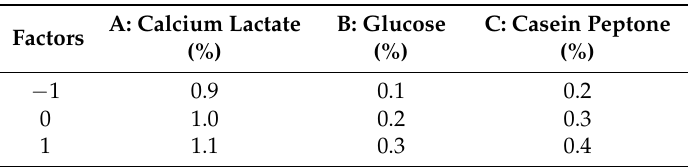
Table 2. Factors level-coding table of the Box–Behnken (B–B) design for peptide production- promoting